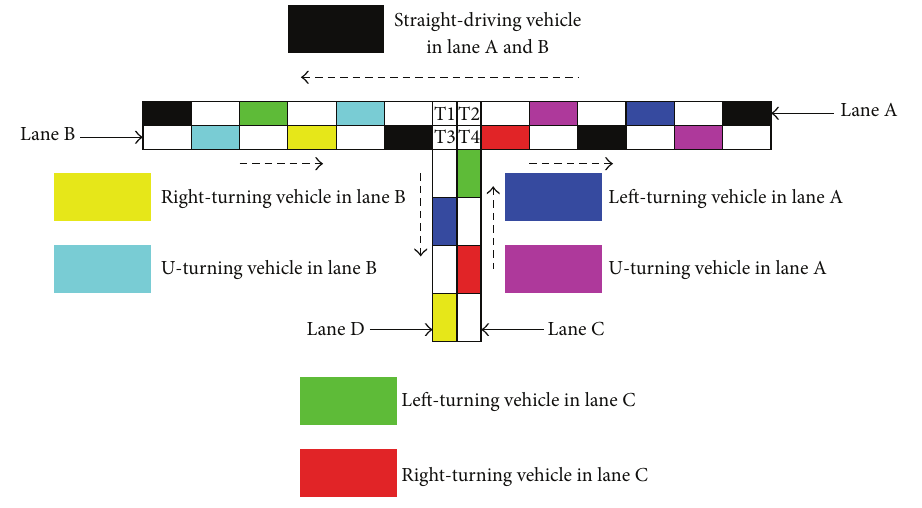
Figure 2: Type of nonsignalized T-shaped